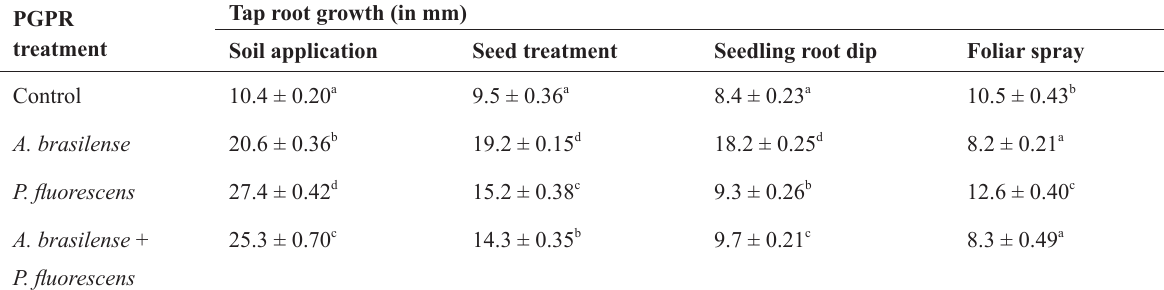
Average of three replicates; ± = SE; Differences between control and treated significant at p= 0.01(Student’s t-test) where superscript of control and treated are different; where superscript same, difference insignificant.